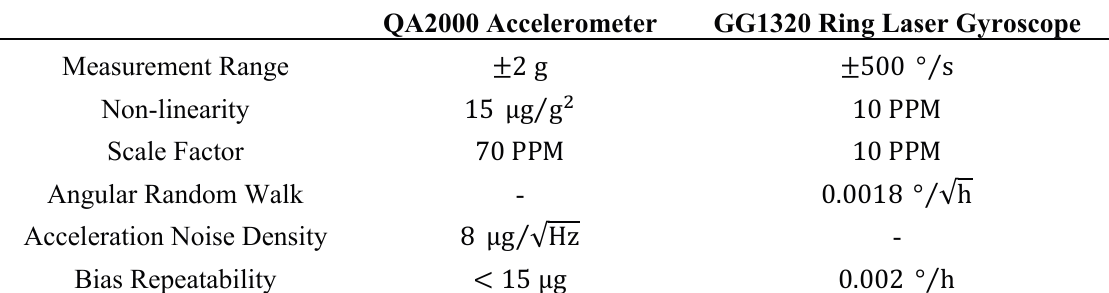
Figure 3. iNAV-RQH IMU. Table 1. Performance characteristics of